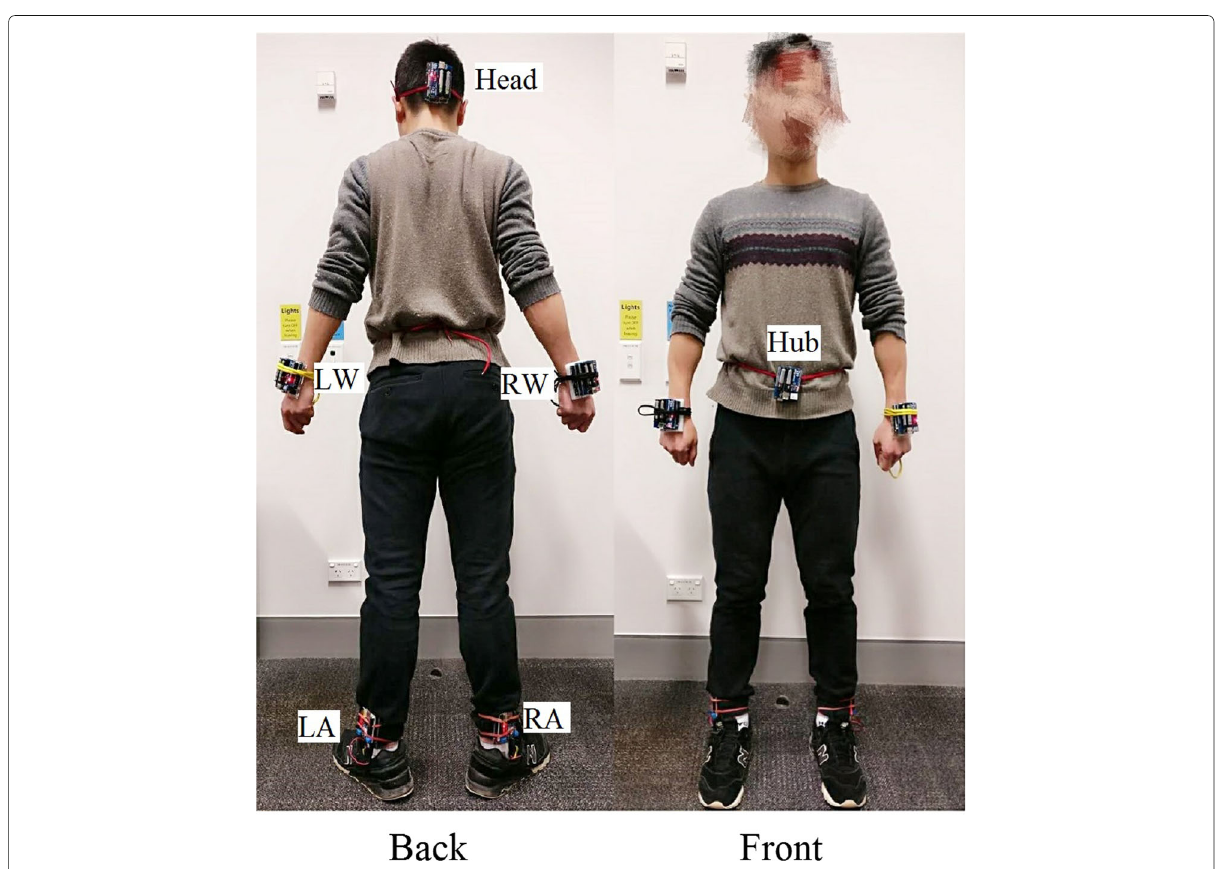
Fig. 1 The deployment of transceivers